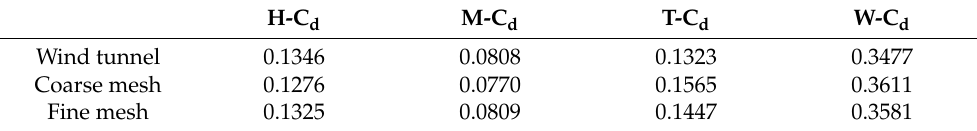
Table 2. Comparison of Cd among numerical simulations and wind tunnel experiment.